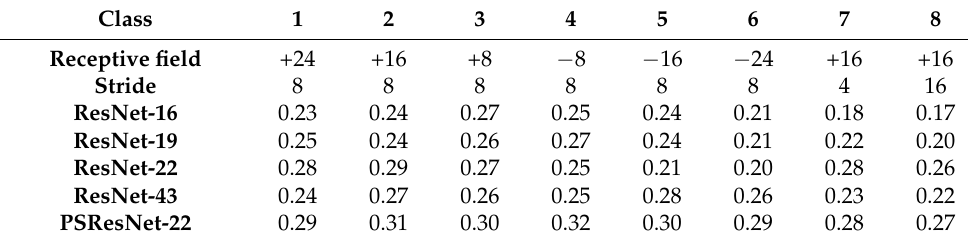
Table 5. Ablation over a different receptive field and stride.